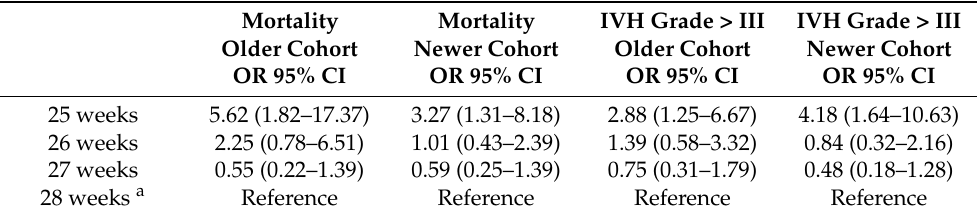
Table 3. Odds of mortality and IVH grade III or higher by study period and gestational age.